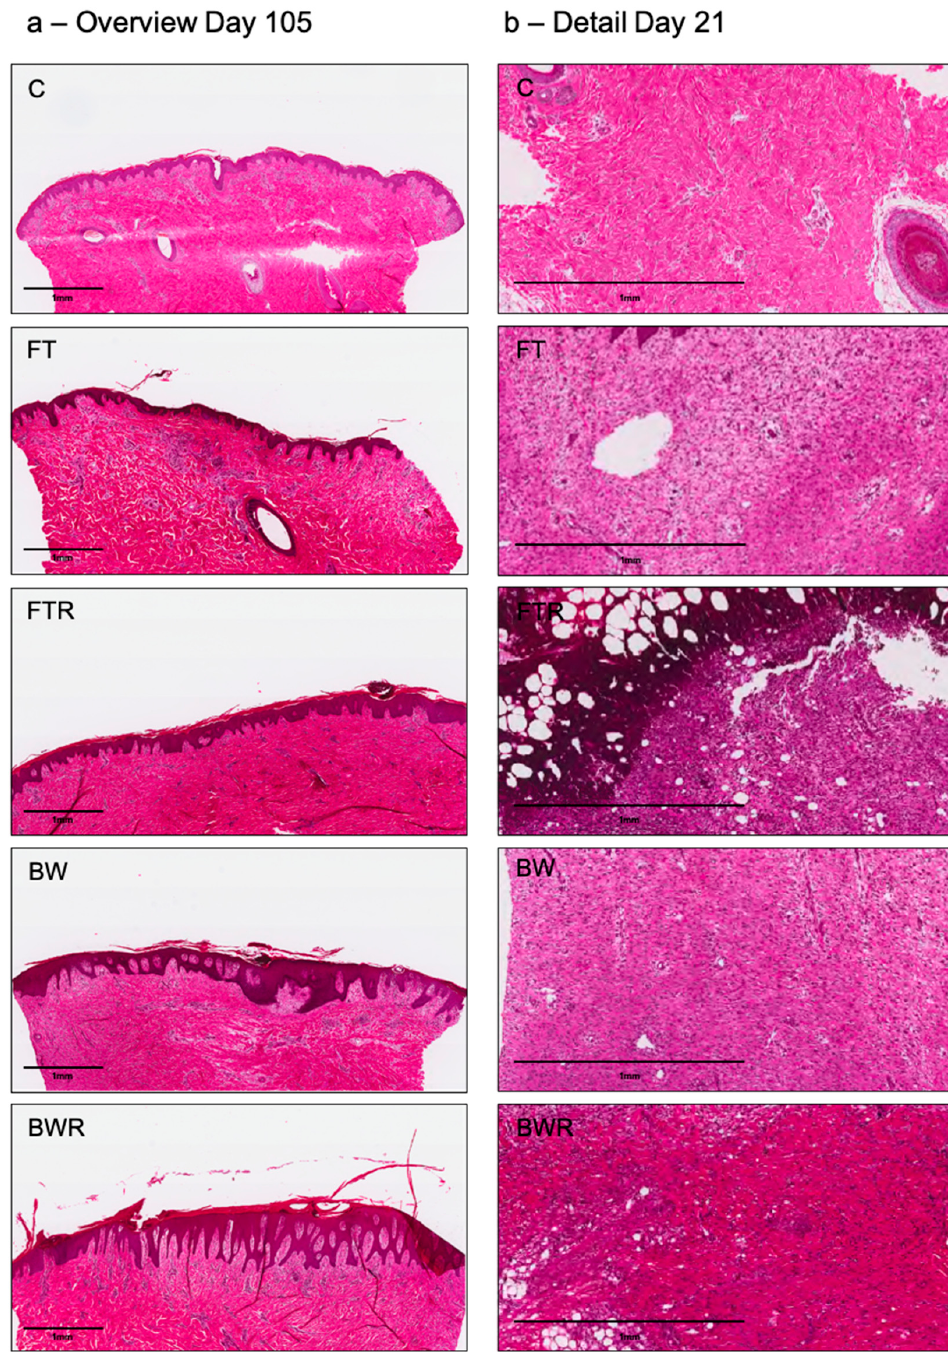
Figure 3. Representative histological sections of the different wound types in hematoxylin/eosin staining (Top to bottom: Control (C), full ‐ thickness wound (FT), full ‐ thickness wound with resiquimod (FTR), burn wound (BW), burn wound with resiquimod (BWR)). The left column ( a ) shows an overview of the biopsies at day 105 with significantly thicker epidermis in the burn wound and the resiquimod-induced wounds typical of human hypertrophic scars. The right column ( b ) shows a larger dermal section of the respective wound types on day 21. Upon quantification (not shown, see Figure 4), inflammatory cell invasion was significantly higher in FTR wounds compared to all other wound